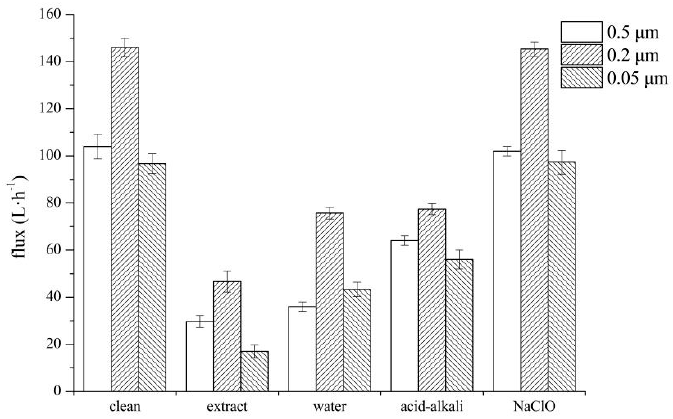
Figure 2. Flux changes of ceramic membranes under different treatment conditions, (0.1 MPa, 550